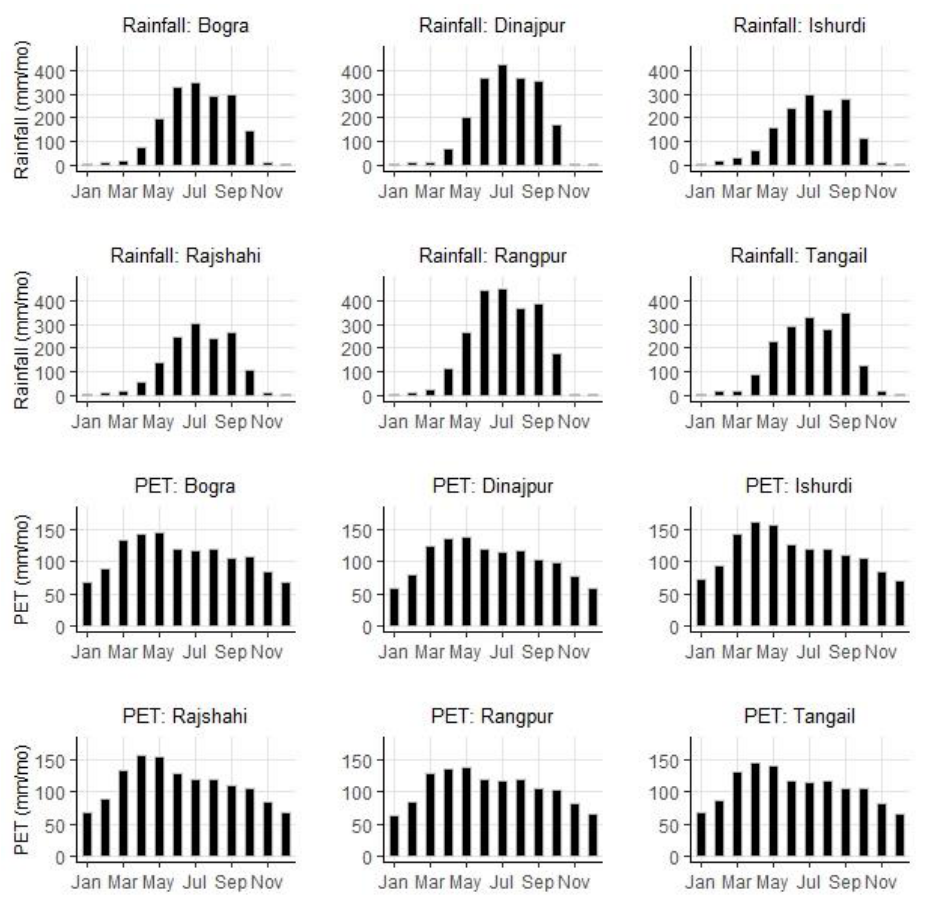
Figure 2. Monthly mean rainfall and potential evapotranspiration (PET) (based on data from 1985 to 2015) at six meteorological stations in the northwest region of Bangladesh (refer to Figure 1 for location).